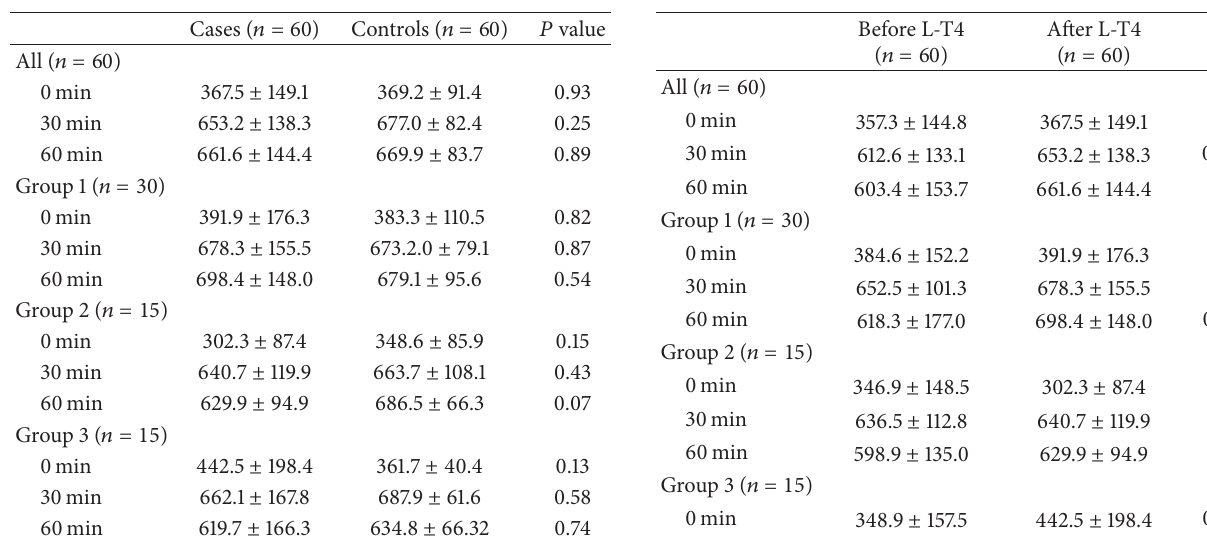
Table 4: Comparative cortisol values to cosyntropin after LT-4 replacement therapy between cases and their age-matched controls (nmol/L).